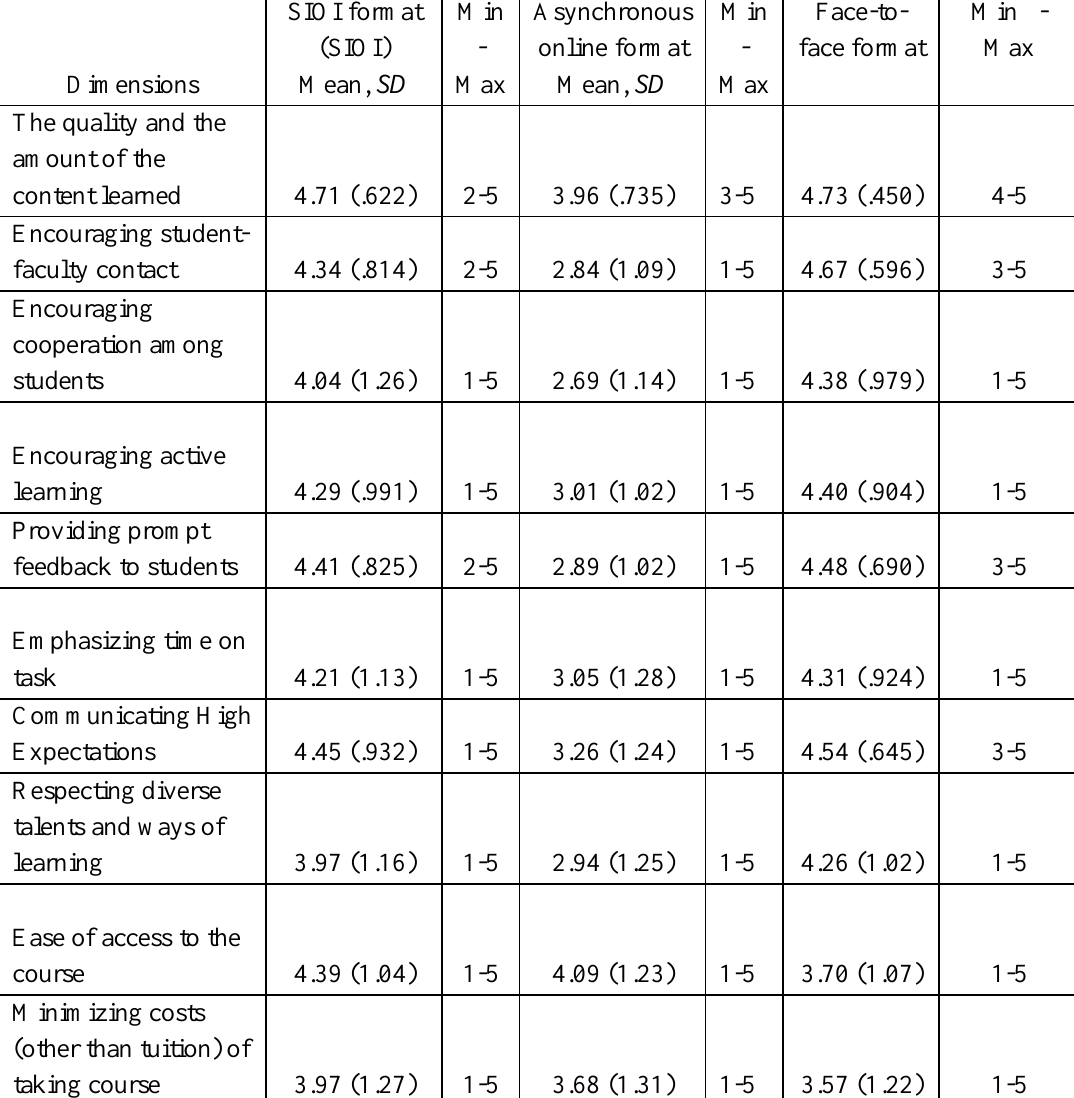
Table 6 Mean Student Ratings of the Quality of Course Formats Relative to Dimensions of Effective College